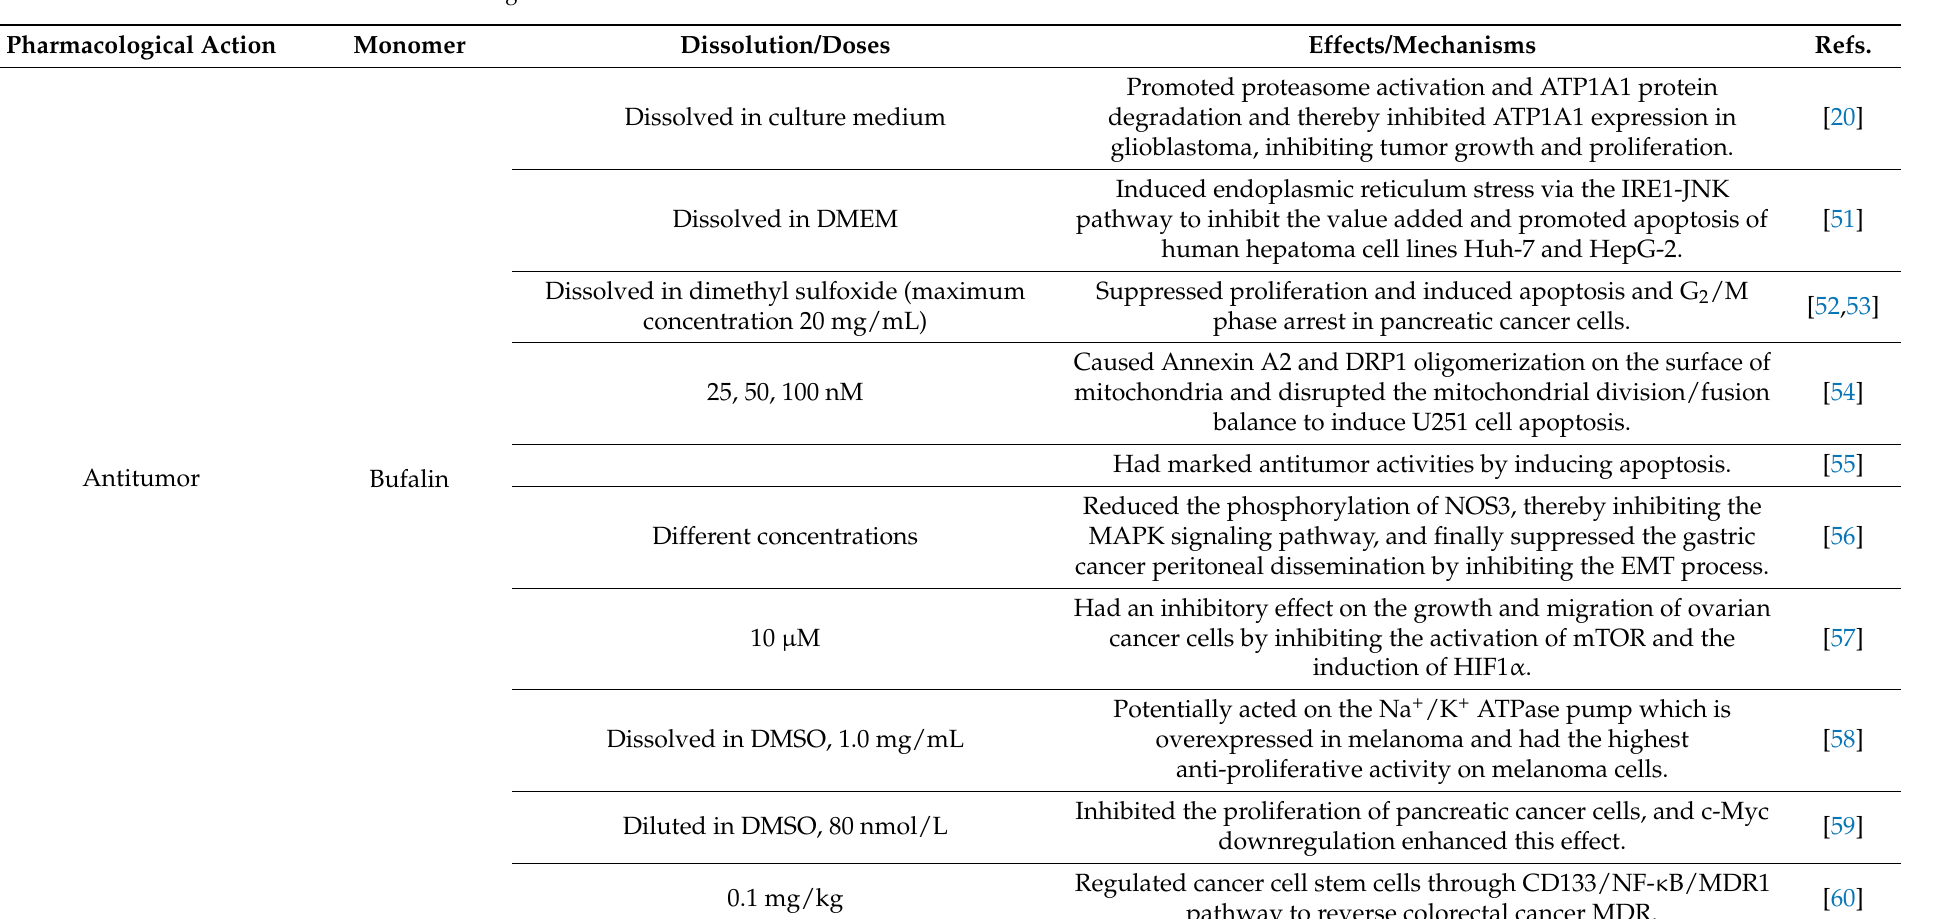
Table 1. Pharmacological activities of